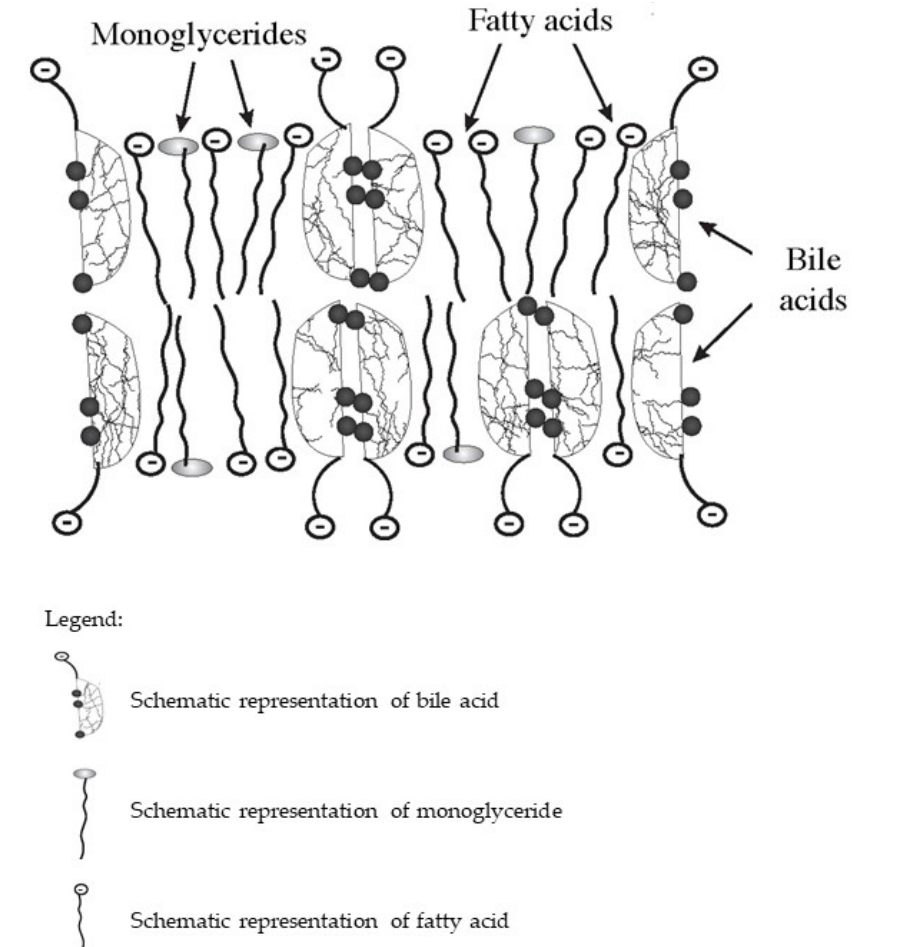
Figure 1. Schematic diagram of the composition of lipoid-bile complexes formed in the small bowel.